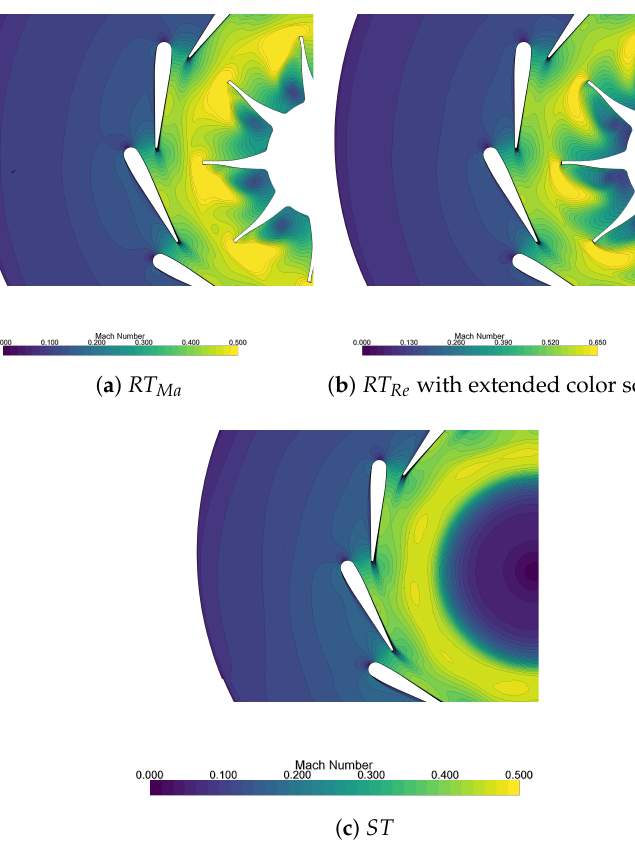
Figure 6. Mach number distribution at stator midspan. ST & RT. VGT30. 0.5 mm tip height.